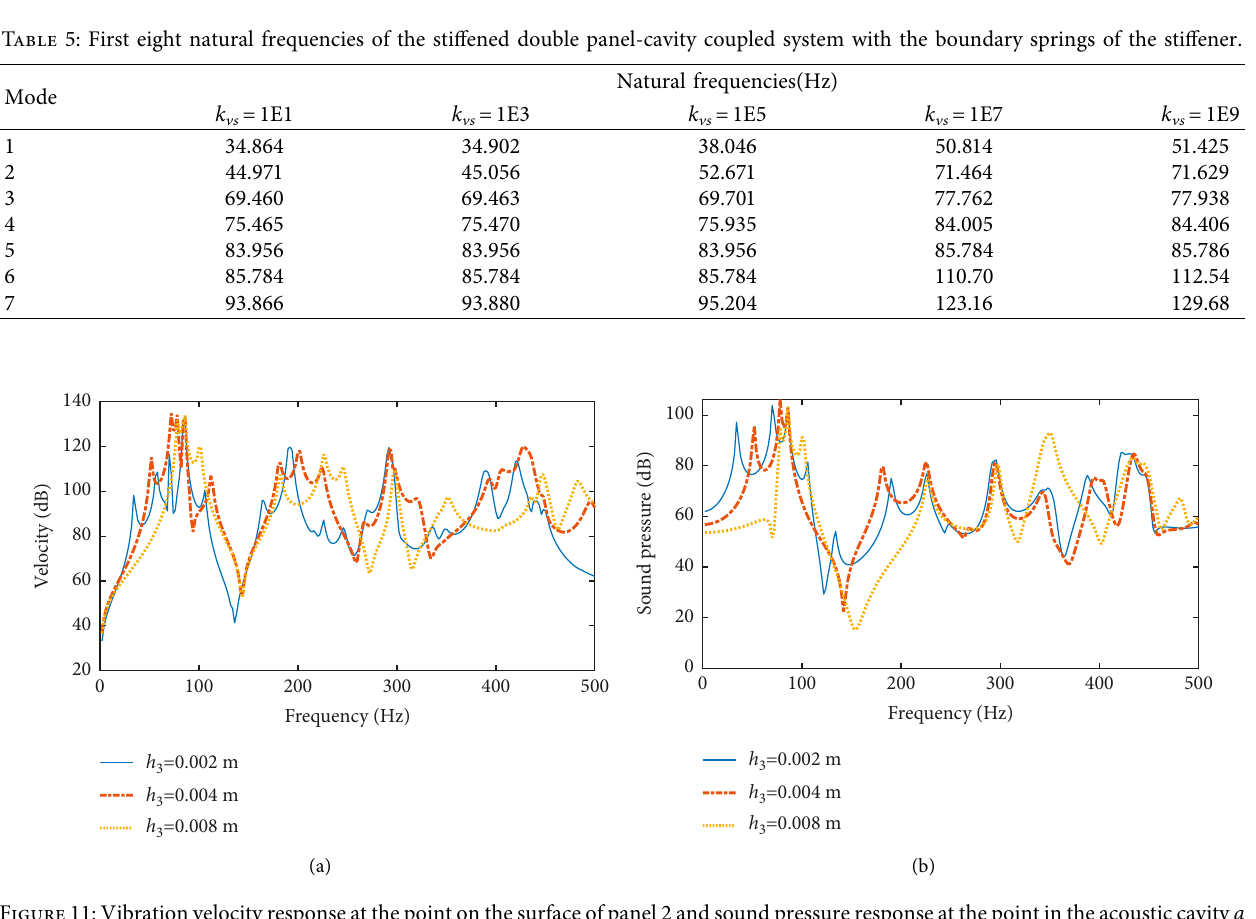
Figure 11: Vibration velocity response at the point on the surface of panel 2 and sound pressure response at the point in the acoustic cavity a with different h 3 : (a) vibration velocity response and (b) sound pressure